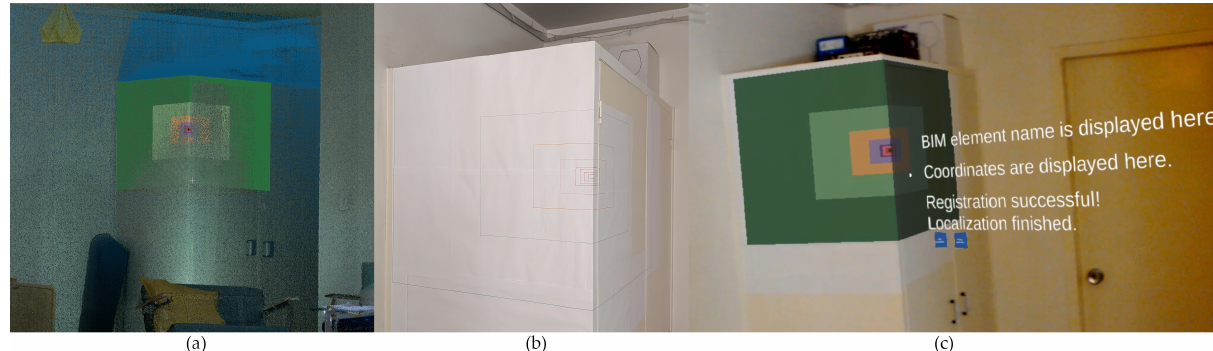
Figure 4. Cubes used for the empirical evaluation of retrieval success rate in (a) the virtual world, (b) the real world and (c) in mixed reality with the worlds